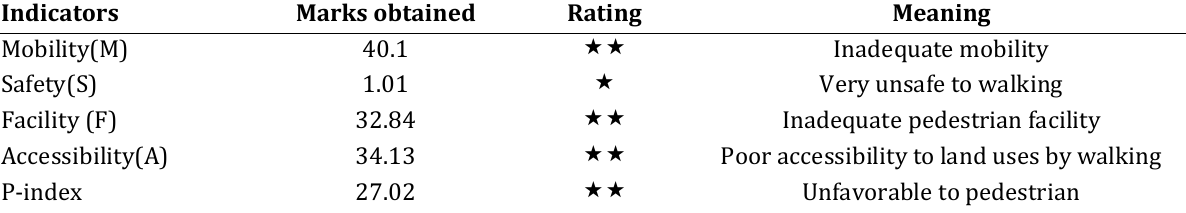
Table 9: Summary of an overall assessment of pedestrian infrastructures in Jimma city Indicators Marks